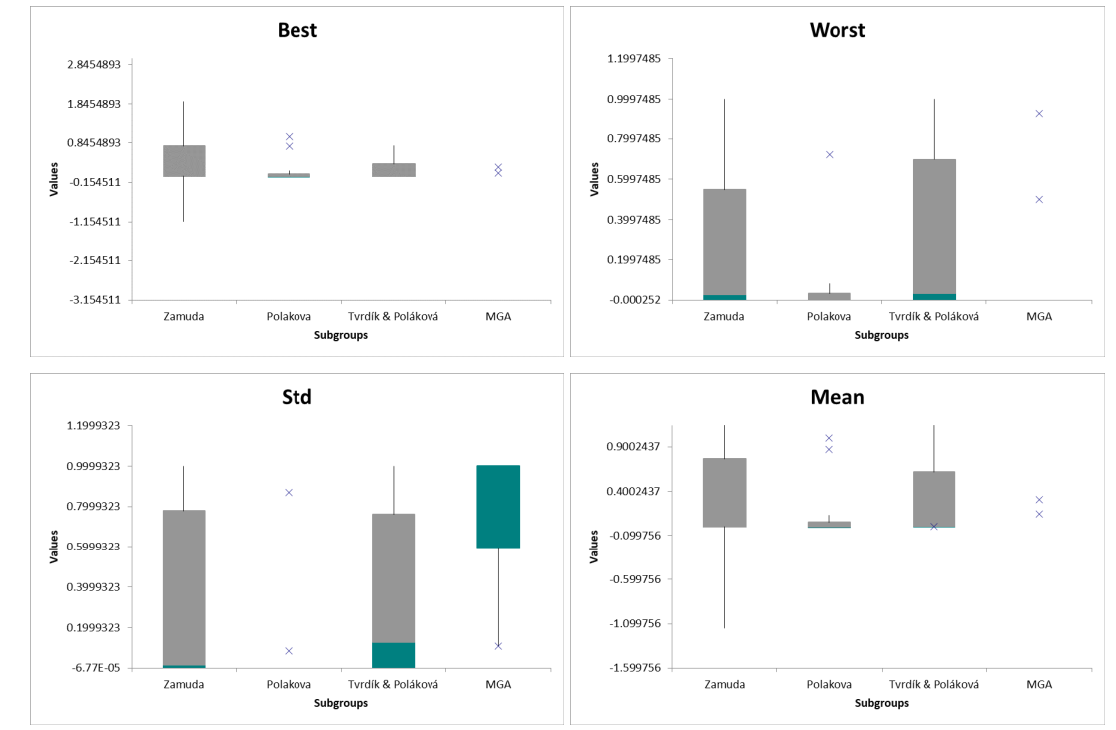
Figure 9. Box plots of the ANOVA for the 50-dimensional problems.